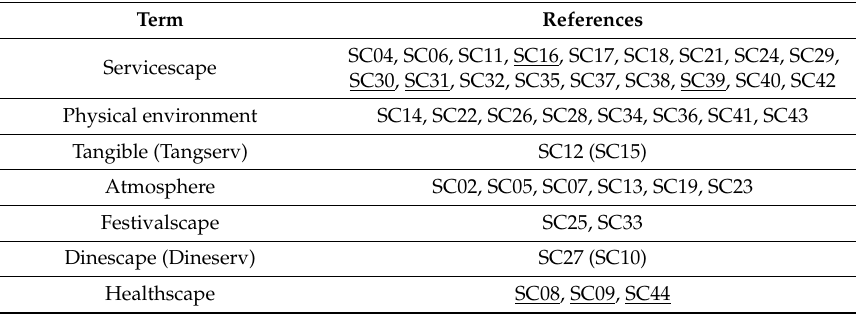
Table 1. Frequency analysis findings of servicescape terminology.